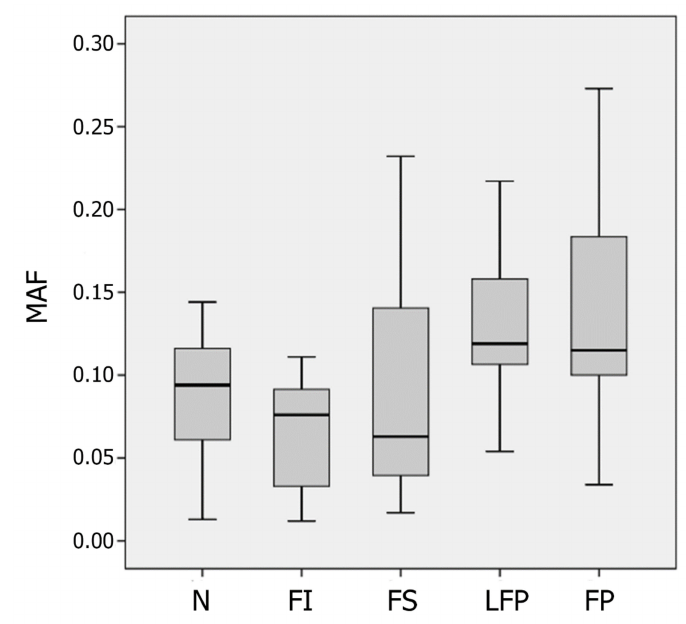
Figure 4. The boxplot showing the mean minor allele frequencies (MAF) values of heteroplasmic mtDNA variants in una ff ected aortic intima (N) and di ff erent types of atherosclerotic lesions (FI, fatty infiltration; FS, fatty streaks; LFP, lipofibrous plaque; FP, fibrous plaque). Table 3. Contingency table for minor and major variants in heteroplasmic mutations. The Type of Atherosclerotic Lesion Parameter N FI FS LFP FP The number of minor variants 68 70 106 113 134 The number of major variants 786 1049 965 732 801